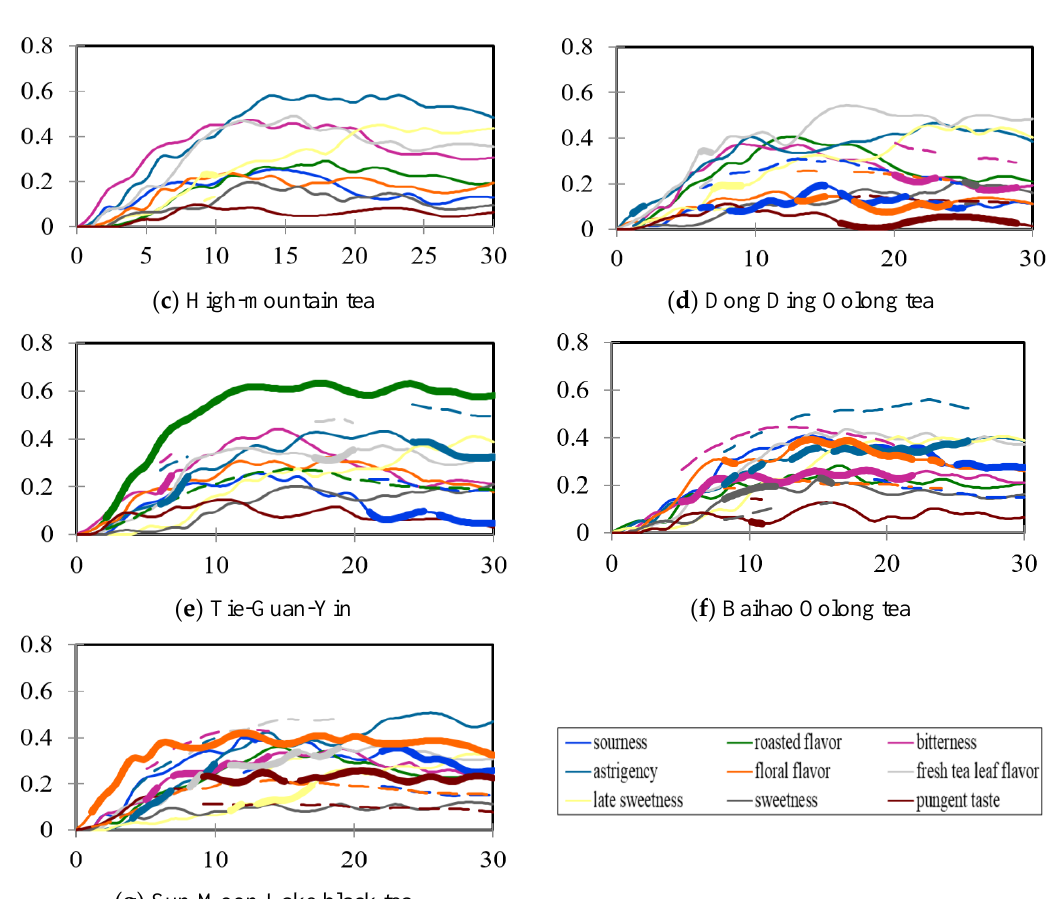
Figure 4. Smooth curves of temporal check-all-that-apply analysis of the nine selected sensory characteristics for the Taiwanese specialty tea infusions ( n = 62). ( a ) Bi-Lo-Chung; ( b ) Wenshen Paochong tea; ( c ) High-mountain tea; ( d ) Dong Ding Oolong tea; ( e ) Tie-Guan-Yin; ( f ) Baihao Oolong tea; ( g ) Sun-Moon-Lake black tea. Dashed lines correspond, for the attribute of interest, to significant reference lines for all other Taiwanese specialty teas pooled together. Significant reference lines are displayed with a thicker line.